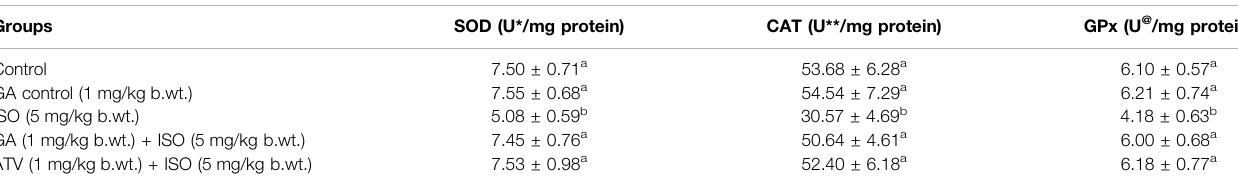
TABLE 5 | Effect of GA on the activities of SOD, CAT and GPx in the heart of control and ISO-induced rats.